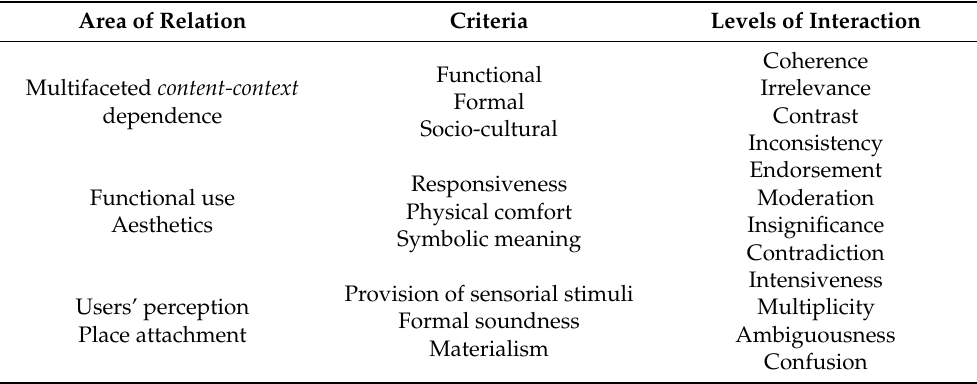
Table 1. Interior components’ performance in function of building materials’ attributes and ap- plied advanced building techniques. The selected area of relation, criteria and levels of qualitative